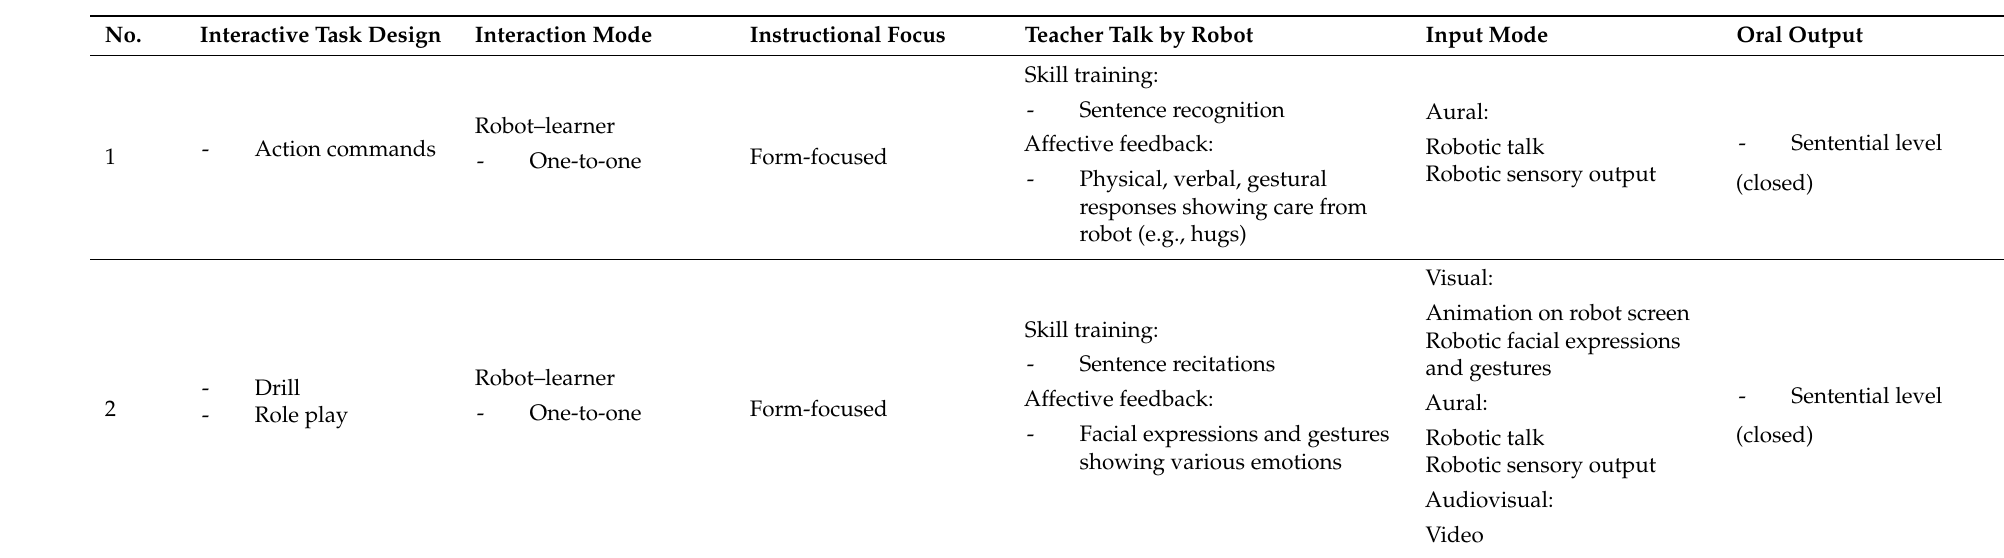
Table A3. Interactive Oral Task Design in